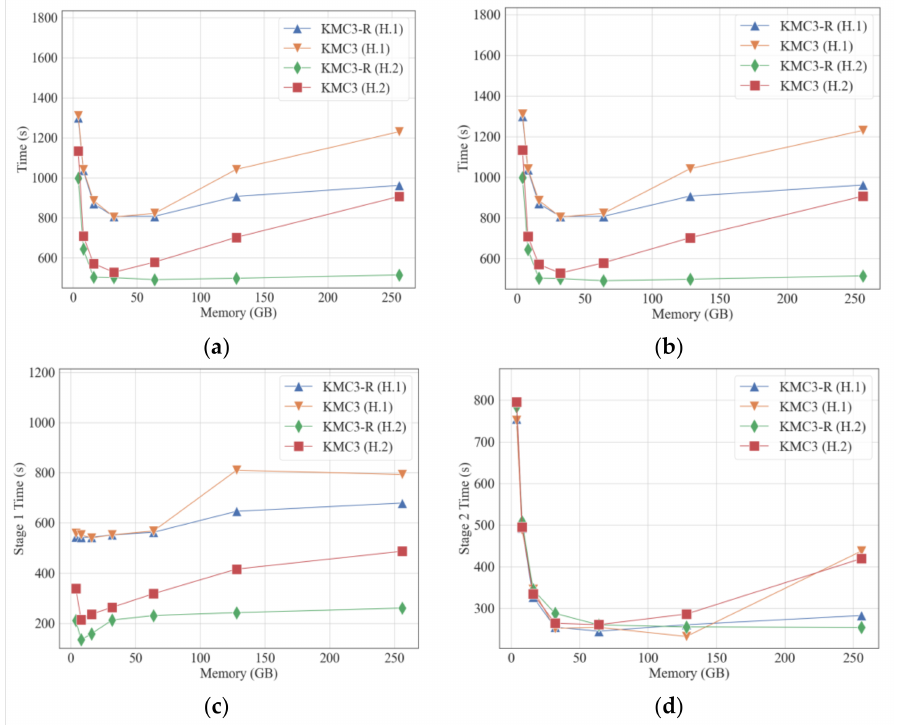
Figure 3. Comparison of KMC3 and KMC3-R in counting 32-mer with various memory limits. KMC3- R: KMC3 with the memory mode. The running time of each stage is collected by timing in KMC3. ( a ) running time; ( b ) actually used memory; ( c ) running time of stage 1; ( d ) running time of stage